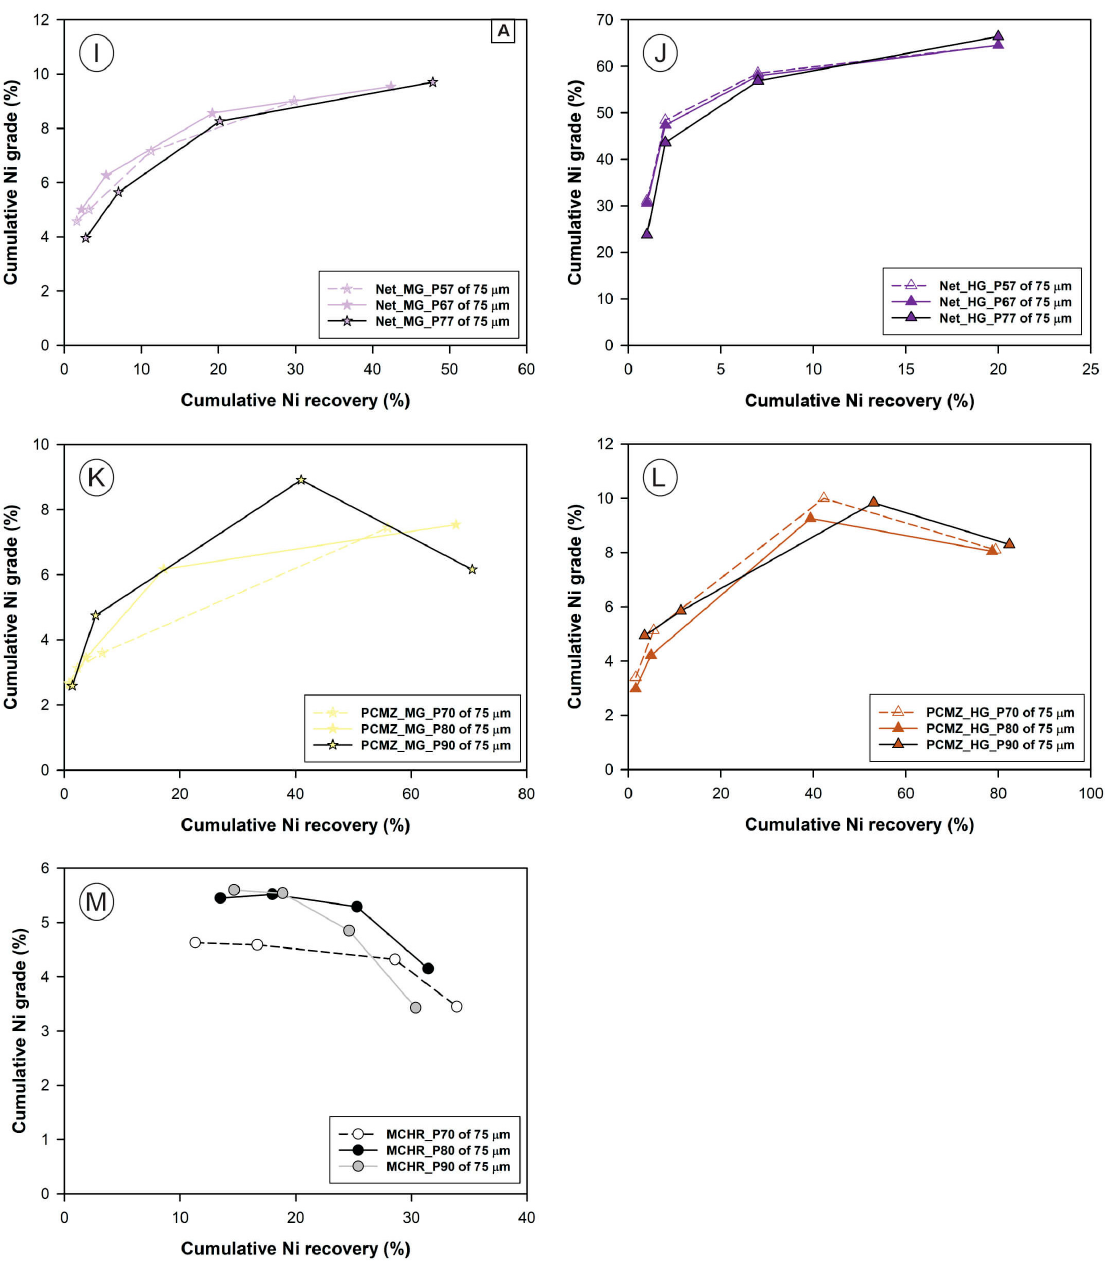
Figure 13. Cumulative concentrate grade vs. cumulative Ni recovery for the flotation of the various ore types at the Nkomati Ni mine, milled to a grind of P57, P67, and P77 at 75 micron (( A – J ) MMZ ore horizon) as well as a grind of P70, P80, and P90 at 75 micron (( K – M ) PCMZ ore horizon).